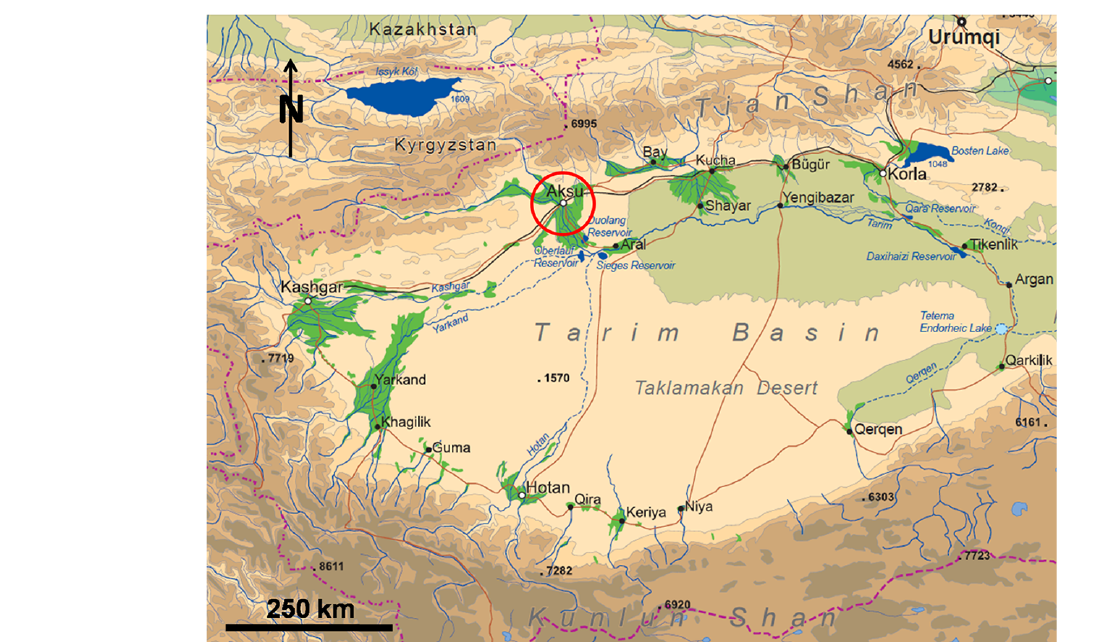
Figure 1. Geographic position of Aksu City in the Tarim Basin, northwest China (adapted from Paproth and Pietsch,